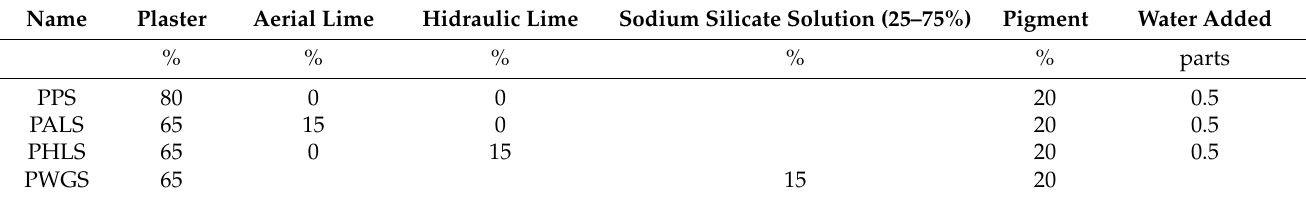
Table 4. Specification and dosage of each gypsum-based paste mix (by volume